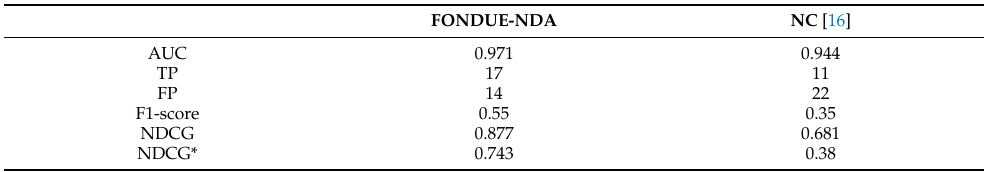
Table 4. Performance of FONDUE-NDA compared to NC for the PubMed dataset